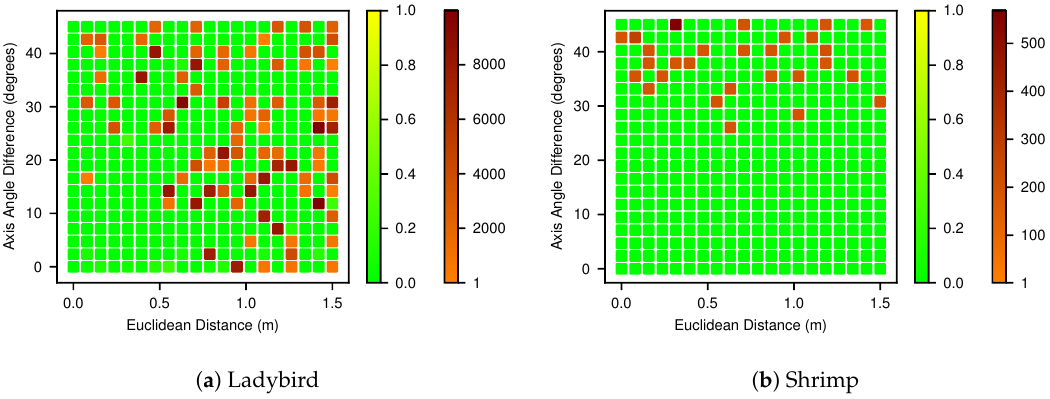
Figure 15. Basins of attractions for the ( a ) Ladybird and ( b ) Shrimp platforms. The x and y axes of the plots are the Euclidean distances and axis-angle rotational differences between the initial values and the optimal reference solution respectively. Each grid cell is colour coded into two tiers based on the Mahalanobis distance of the result to the known optimum: below 0.1 and above, which was chosen as a suitable threshold for optimisation